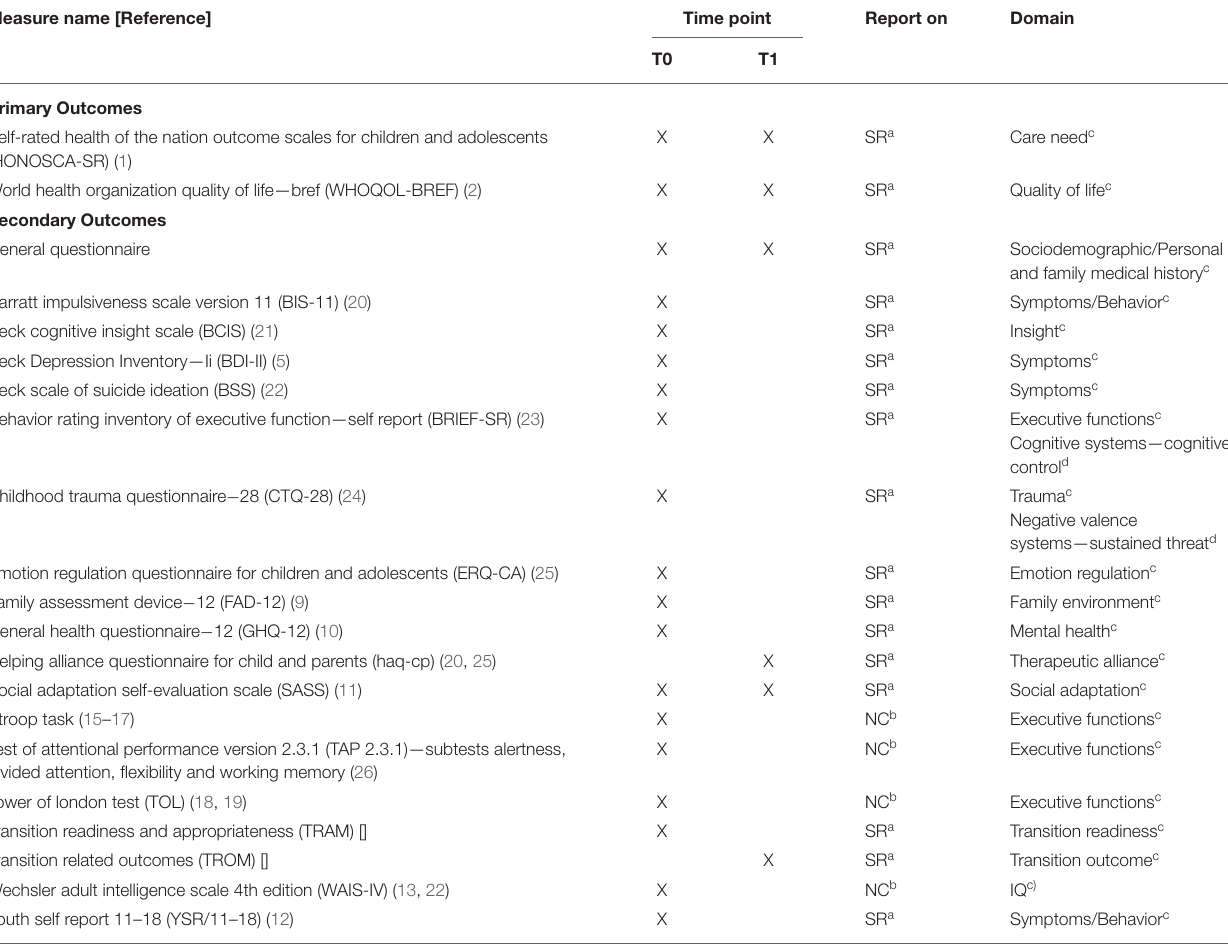
TABLE 2 | Summary information on measures collected at T0 and